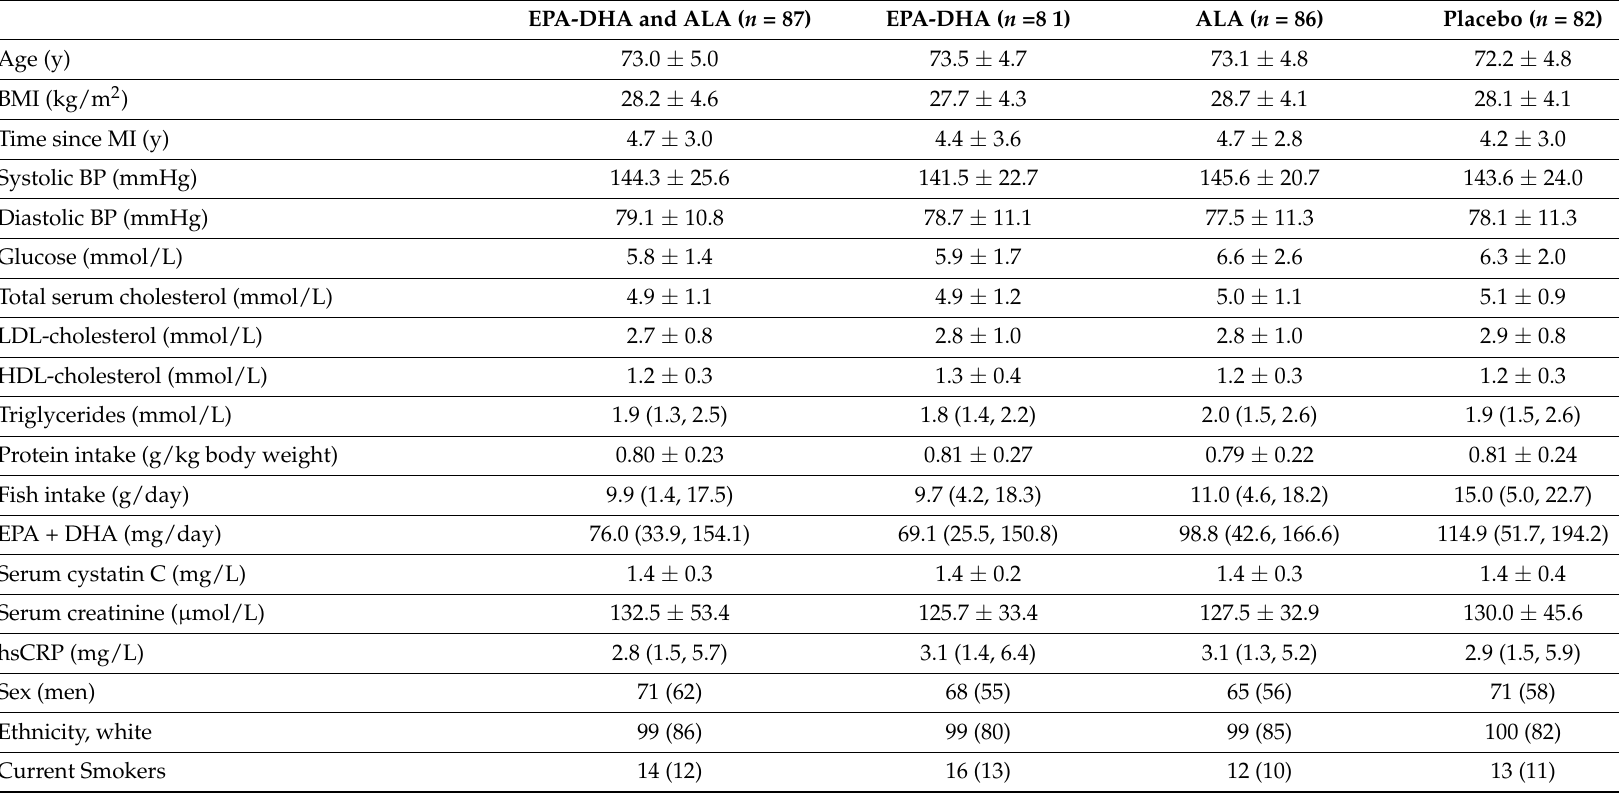
Table 1. Baseline characteristics of 336 patients of the Alpha Omega Trial by treatment group with creatinine–cystatin C-based eGFR< 60 mL/min/1.73 m 2